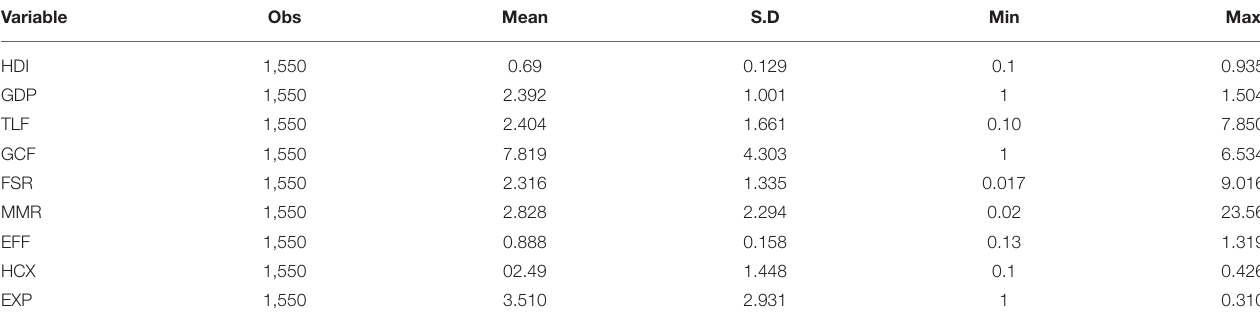
TABLE 2 | Descriptive statistics.